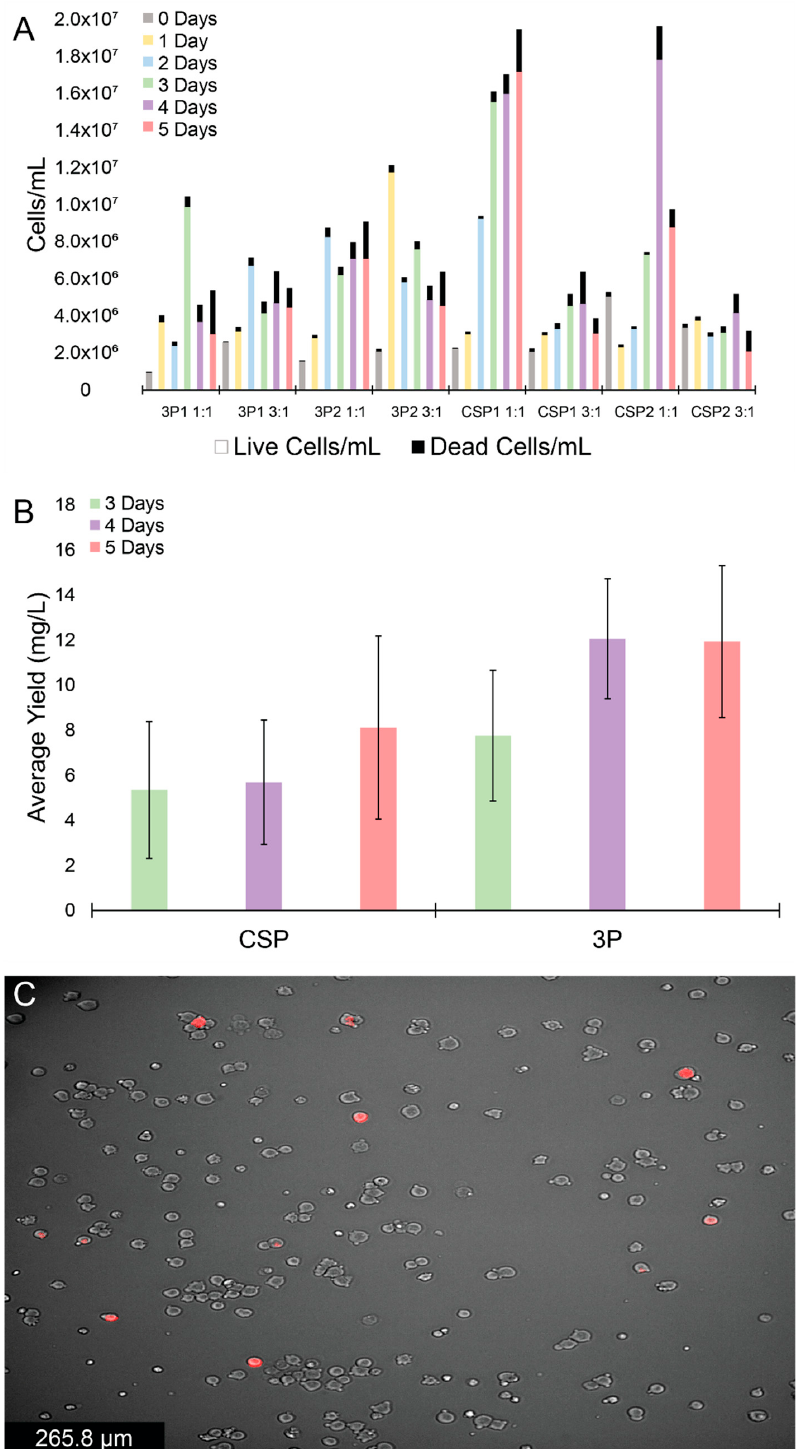
Figure 2 . Expression and cell viability of the 3P and CSP systems using PEI. ( A ) Daily live (colored) and dead (black) cell counts for duplicate 3P and CSP expression systems at PEI:DNA ratios of 1:1 and 3:1. ( B ) Sandwich ELISA assay average yields with standard error bars (mg/L; data taken from four experiments) for 3P and CSP expressions in HEK Expi293 TM cells transfected with 3:1 PEI:DNA ratio, 3–5 days post-transfection. ( C ) Representative fluorescence cell image of recombinant HEK Expi293 TM cells (red) among un-transfected cells